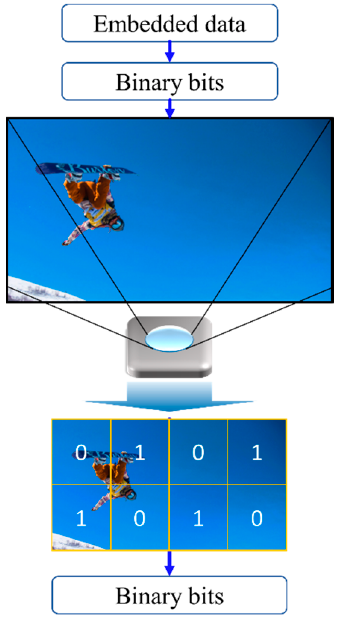
Figure 14. Invisible watermarking OCC.